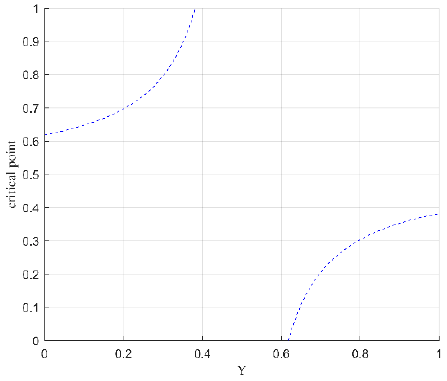
Figure 10. Critical points against each Y .